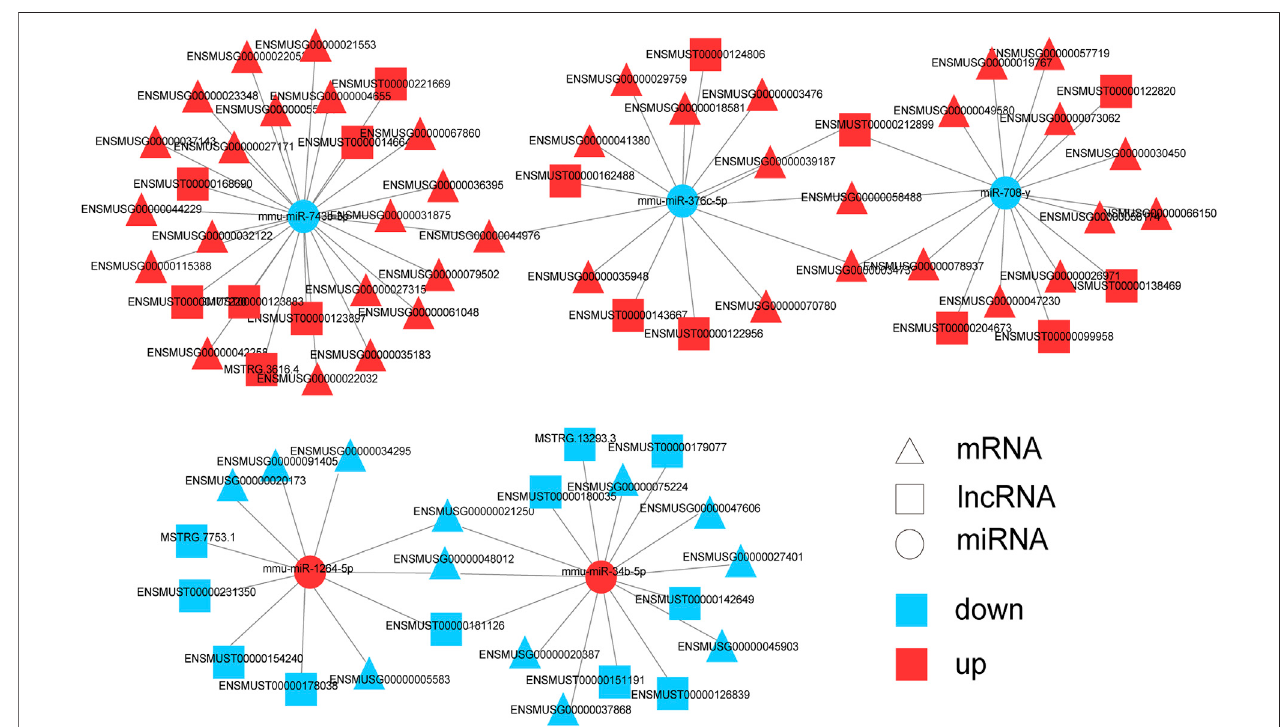
FIGURE7| PredictednetworksofmRNAsrelatedtonervoussystemandcorrelativemiRNAsandlncRNAs.TrianglerepresentsmRNA,squarerepresentslncRNA, and circle represents miRNA. Red: upregulated RNAs; blue: downregulated RNAs.